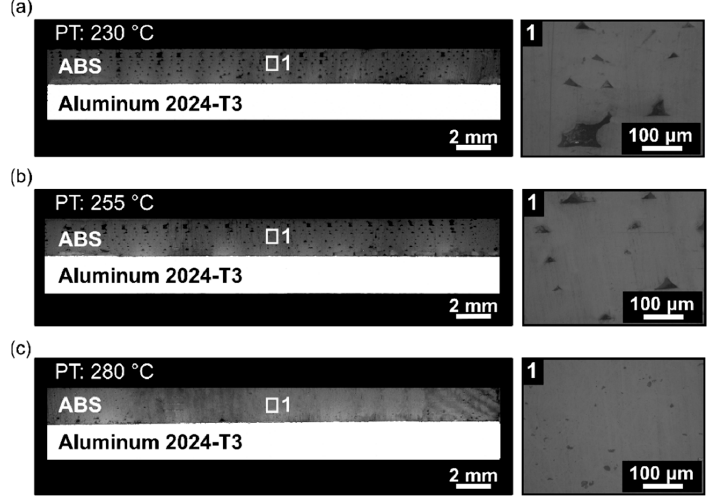
Figure 5. Microstructure of the aluminum 2024-T3/ABS hybrid joints manufactured with different printing temperatures, with detailed view of the pores formed within the ABS part for ( a ) condition one, PT: 230 ◦ C, ( b ) condition two, PT: 255 ◦ C, and ( c ) condition three, PT: 280 ◦ C (the following parameters RT: 0.2 mm, DS: 40 mm/s, AC: 15 wt.%, and NC: 2 were fixed for the conditions